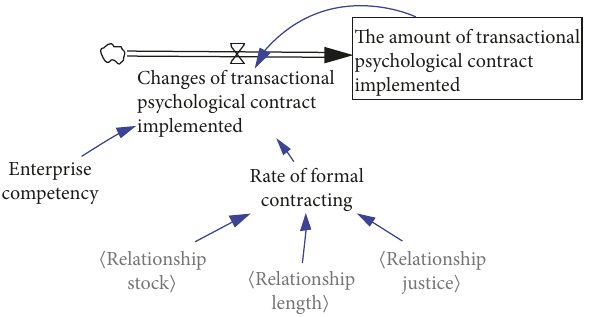
Figure 5: Changes of transactional psychological contract imple- mented (CTPCI) rate variable in-tree branch.